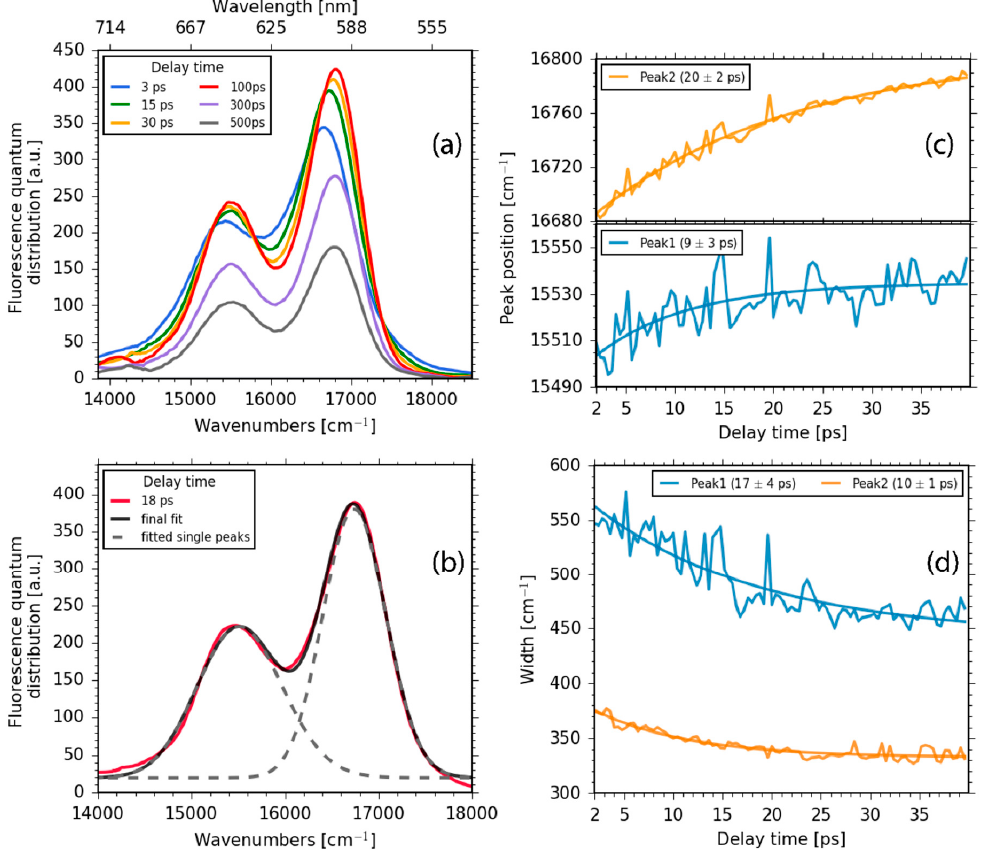
Figure 4. ( a ) Fluorescence spectra for selected delay times. The spectral blue-shift and narrowing of the bands is clearly visible for early delay times, while the overall decay is visible for later delay times; ( b ) Log-normal fit of the Q band fluorescence (dashed lines). lognormal( υ ) = (2 π ) − 0.5 ( συ ) − 1 exp{[ln( υ ) − μ ] 2 /[2 σ 2 ]} + c, with the standard deviation σ and the mean value μ . The fit was used to determine the peak positions and peak widths (full width at half maximum (FWHM)); ( c ) Transient spectral blue-shift of the peak positions; ( d ) Narrowing of the fluorescence peaks as a function of time.